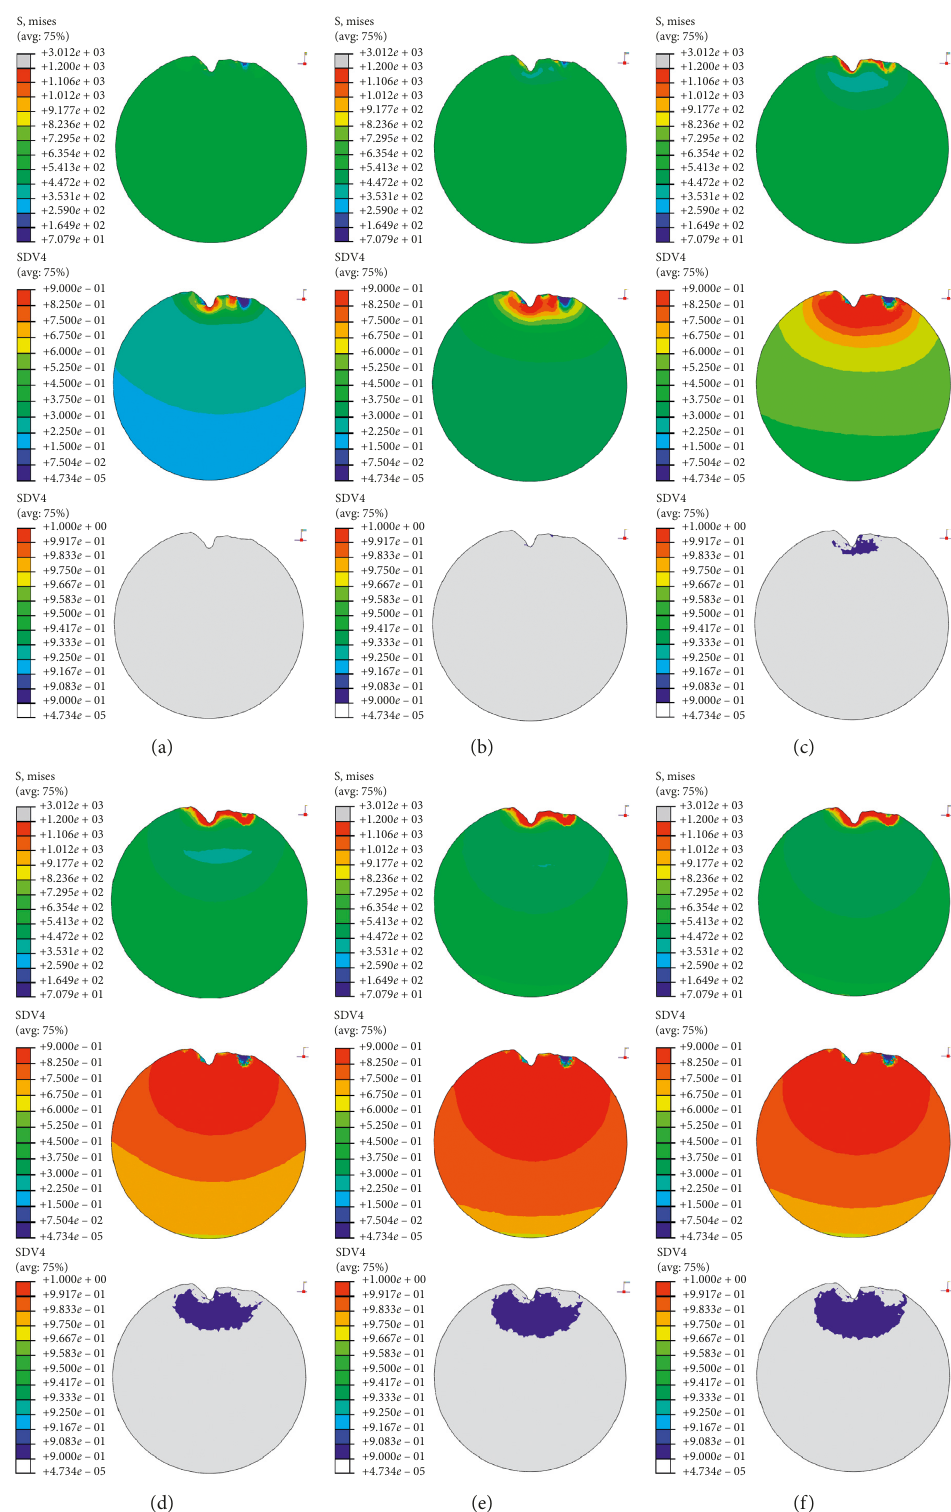
Figure 14: CF damage evolution and stress distribution of high-strength steel wire (view cut: z � 7